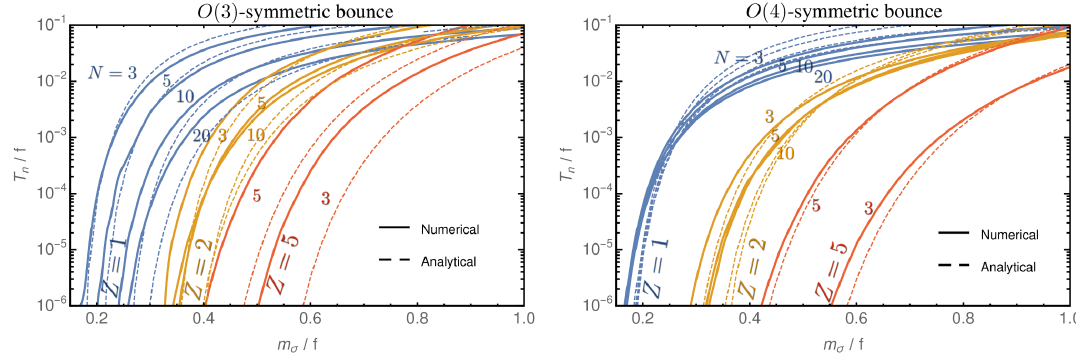
Figure 11 . We compare the nucleation temperature computed after numerically solving for the O (3) - or O (4) -bounce action with the overshoot-undershoot method, to the analytical approximations in the thick-wall limit presented in section B.2. Right: the O (4) analytical formula, in eq. (B.18), is a quite good approximation. Left: the O (3) case, in eq. (B.15), while relatively good approximation for Z = 1 , worsens for larger Z . This was expected since it has been derived in the conformal limit γ (cid:15) → 0 .